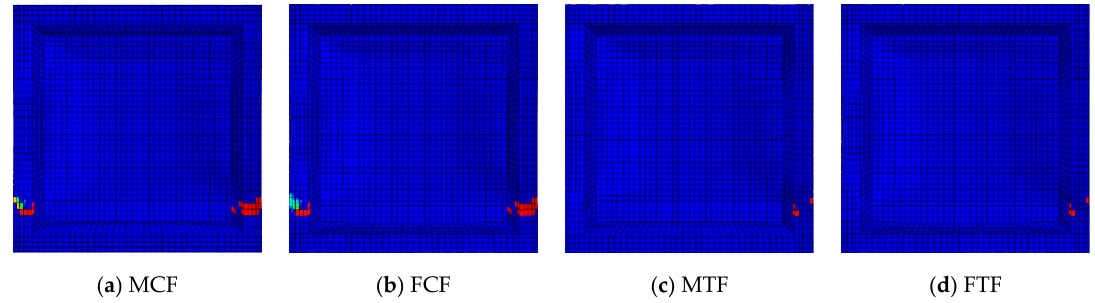
Figure 19. Failure modes of inner skin in the CD0 Model. ( a ) Matrix compressive failure (MCF); ( b ) Fiber compressive failure (FCF); ( c ) Matrix tensile failure (MTF); ( d ) Fiber tensile failure (FTF).